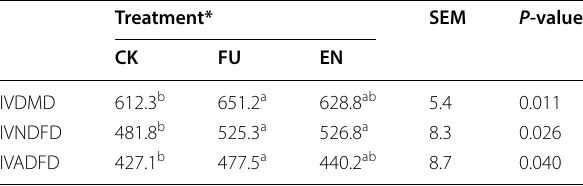
IVDMD: In vitro dry matter digestibility; IVNDFD: in vitro neutral detergent fibre digestibility; IVADFD: in vitro acid detergent fibre digestibility; SEM: